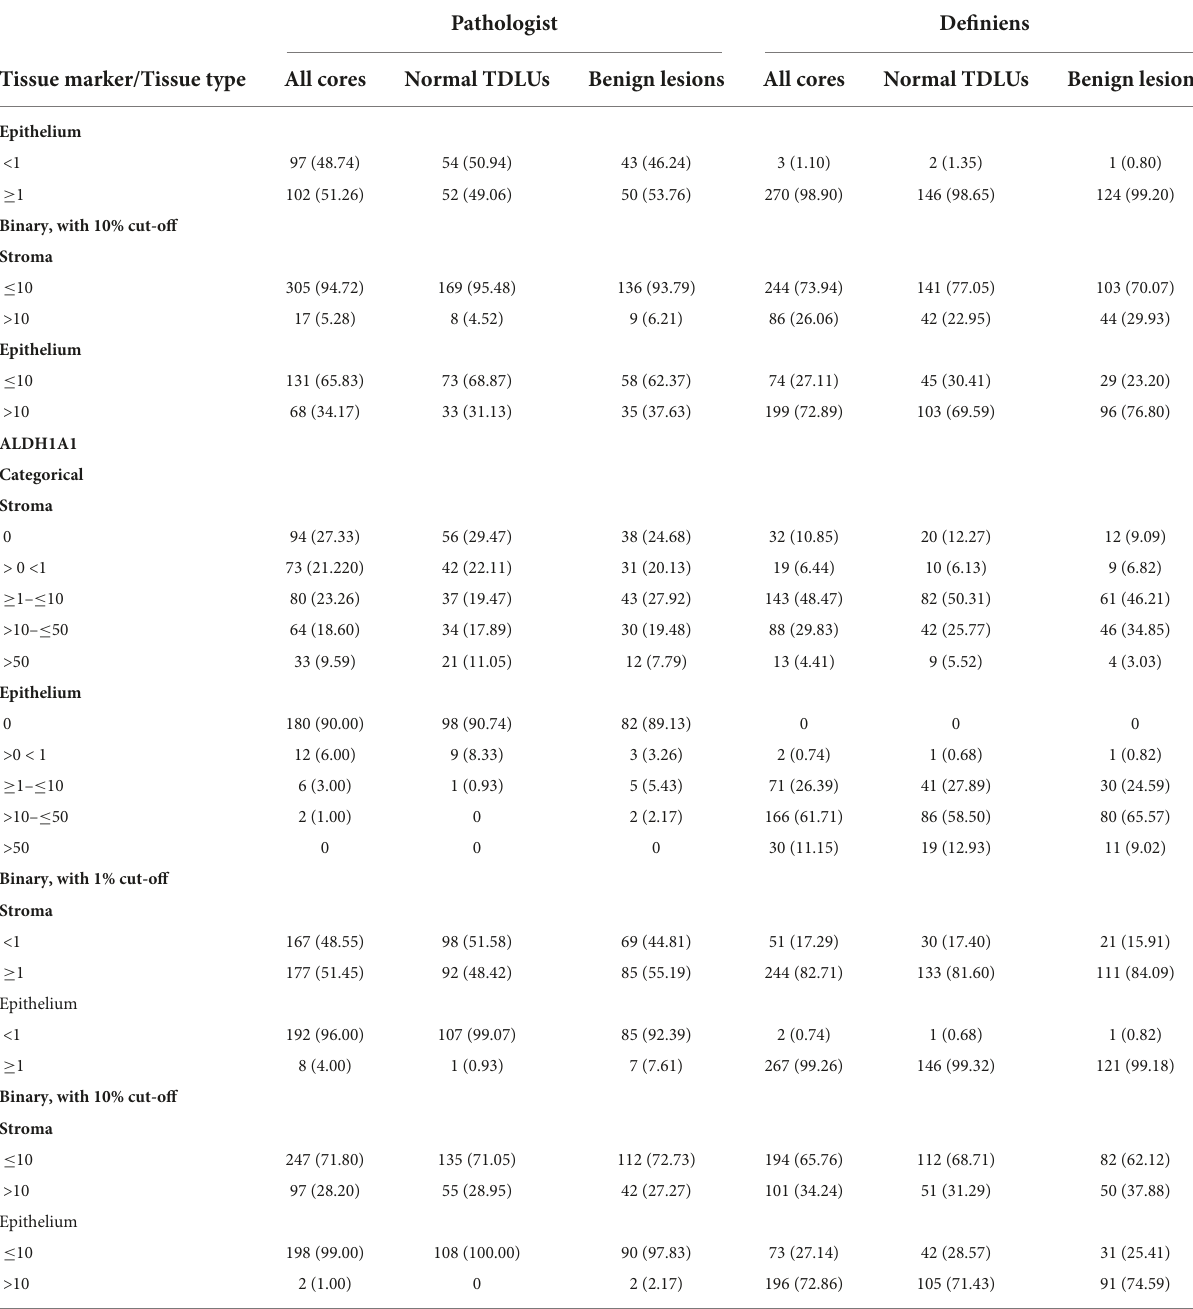
For epithelium, strong correlations were observed for marker expression readings for CD44 for normal TDLU cores ( r = 0.68, 95% CI 0.55; 0.78) and benign lesions ( r = 0.61, 95% CI 0.46; 073) and for CD24 for normal cores ( r = 0.66, 95% CI 0.53; 0.76) and benign lesions ( r = 0.64, 95% CI 0.49; 0.75); no correlations were found for